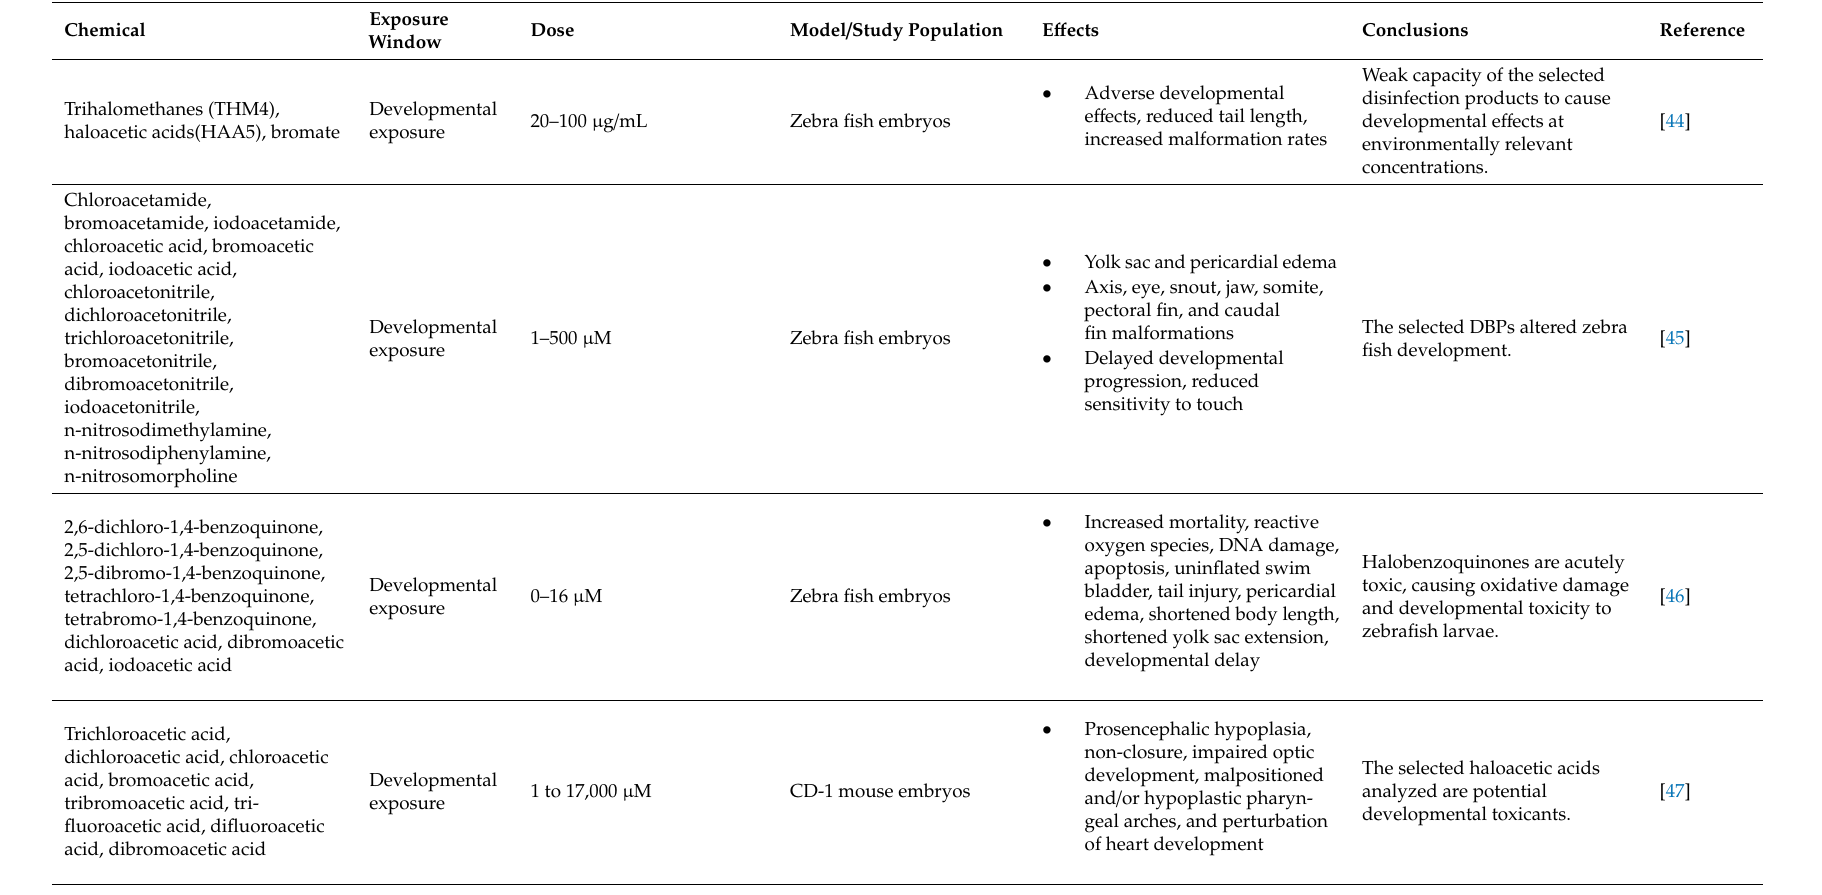
Table 2. E ff ects of DBPs on the Reproductive